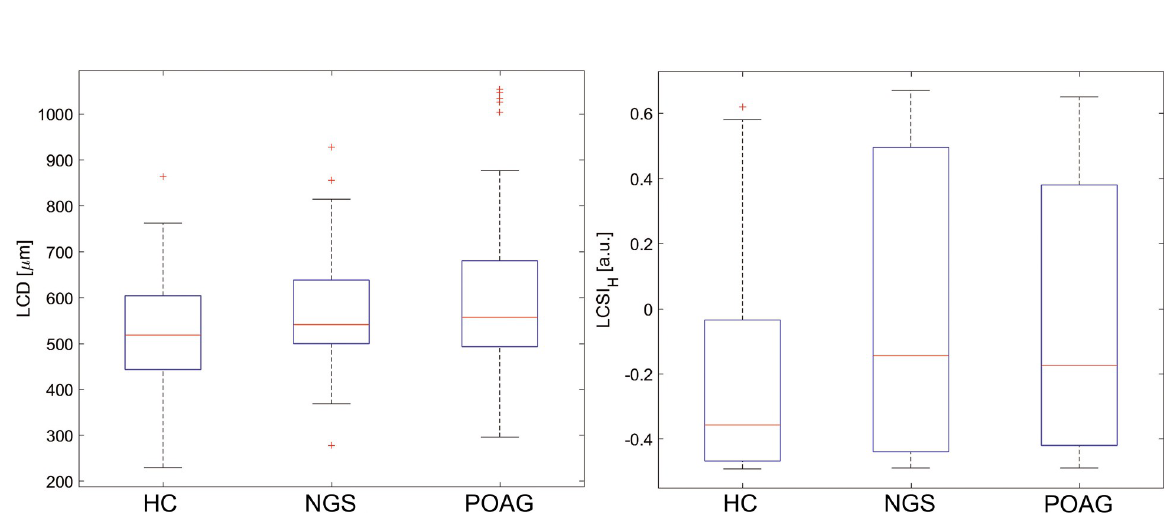
Fig 2. The boxplots for LCD (left) and LCSI H (right) for the three considered groups of subjects. Red crosses denote